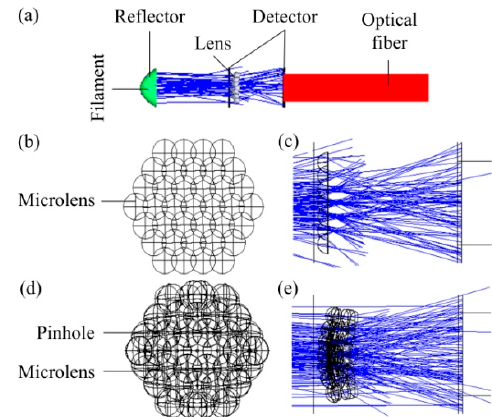
Figure 5. Simulated optical system: ( a ) Structural view of the virtual optical system; ( b ) Spliced microlens array structure view; ( c ) The ray tracing result of the planar microlens array; ( d ) Spliced compound eye structure view; ( e ) The ray tracing result of the compound eye.